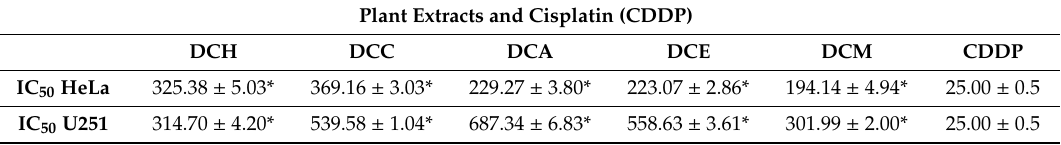
Table 6. IC 50 ( µ g / mL) of the plant extracts and cisplatin (CDDP) (control) toward the HeLa and U251 cell